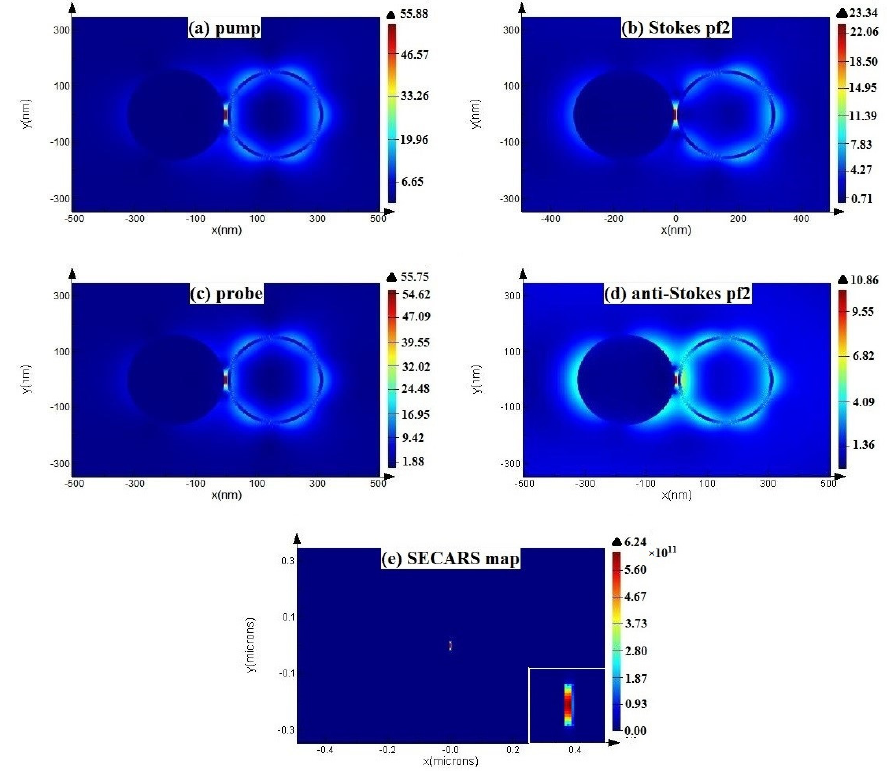
Figure A6. Transient distributions of the electric field of ( a ) pump, ( b ) Stokes, ( c ) probe, ( d ) anti-Stokes light, and ( e ) corresponding SECARS map at 7128.3 fs. The white box in ( e ) is an enlarged view of the area with 60 nm × 60 nm in the center of the disk-ring structure.